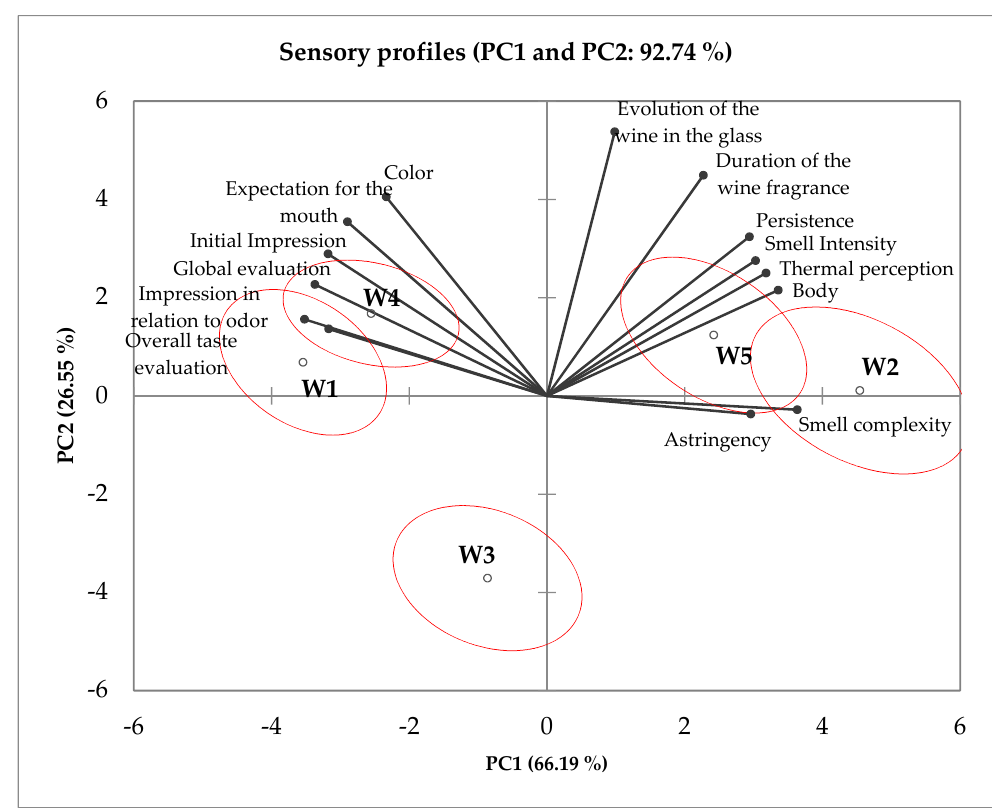
Figure 2. Two-dimensional map made from the PCA of the wine (W) descriptor scores using the emotional tasting sheet of the consumer panel.